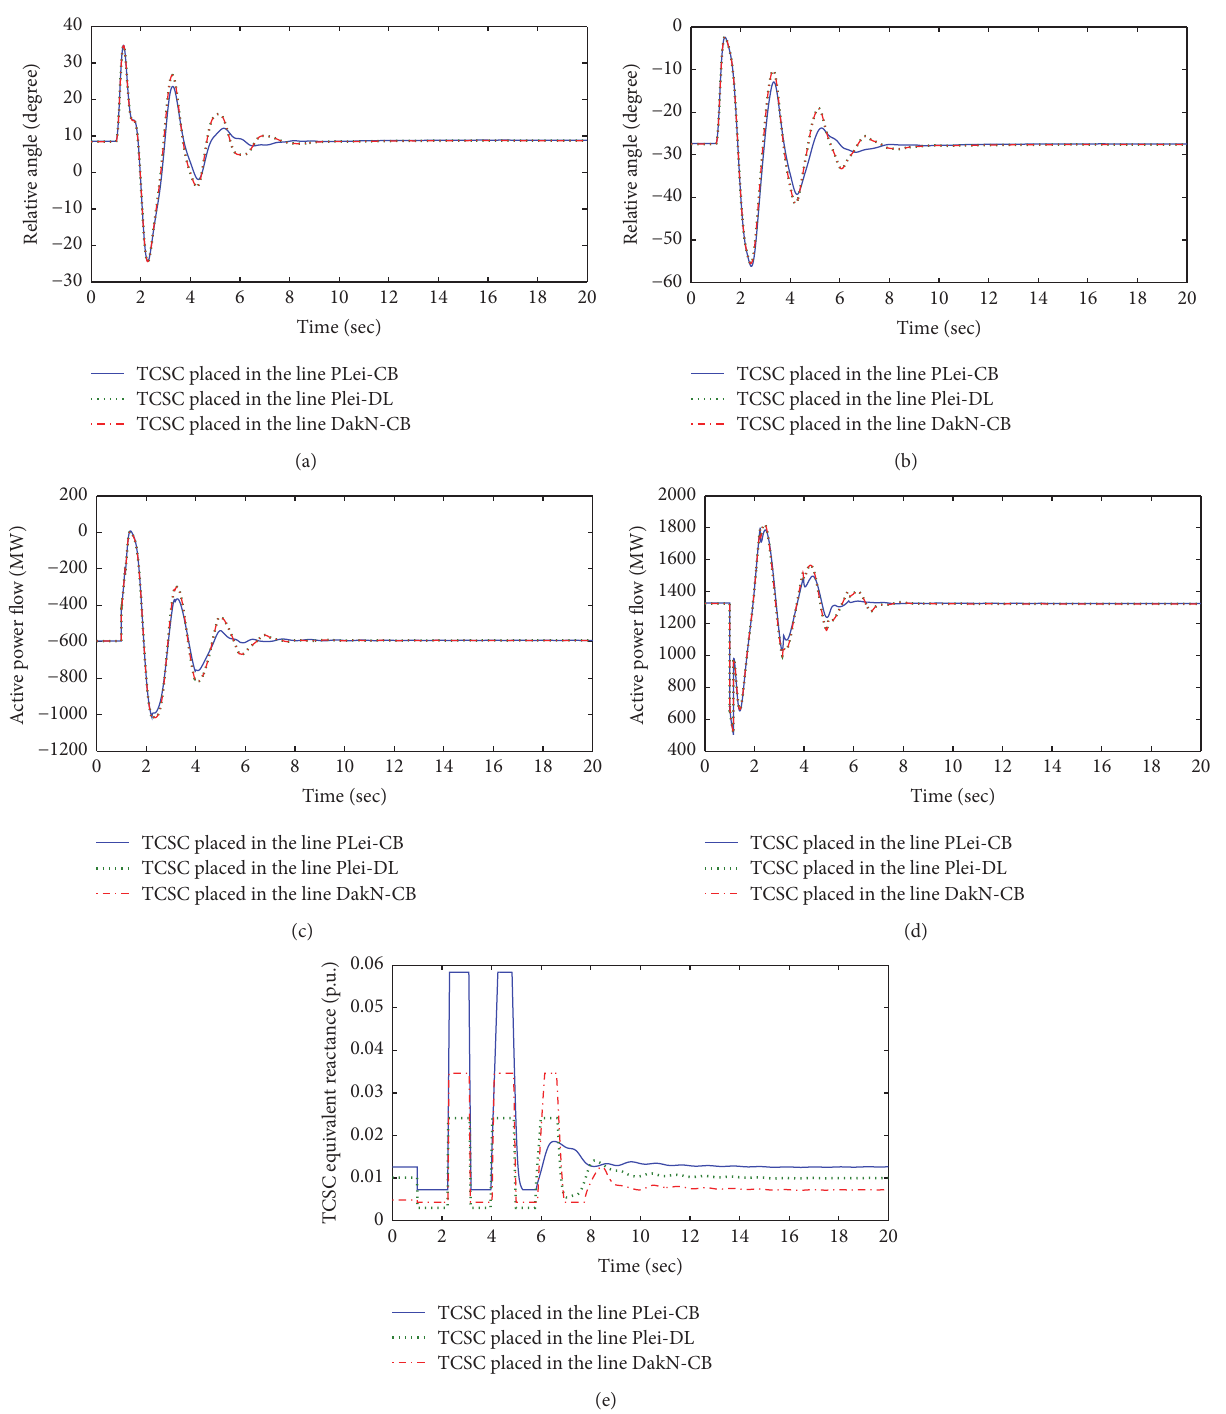
Figure 11: The transient response: (a) the relative angle oscillations of generator VinhTan (b); the relative angle oscillations of generator DuyenHai; (c) the active power oscillations in the line HaTinh-VungAng; (d) the active power oscillations in the line Pleiku-ThanhMy; (e) the response of TCSC